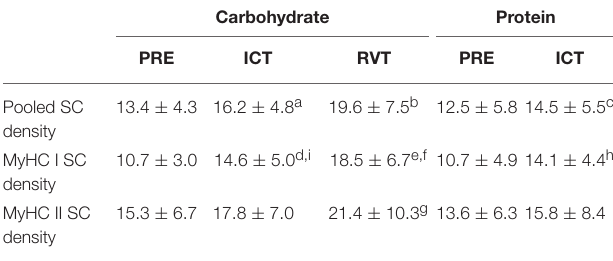
TABLE 2 | Satellite cell density (SCs/100